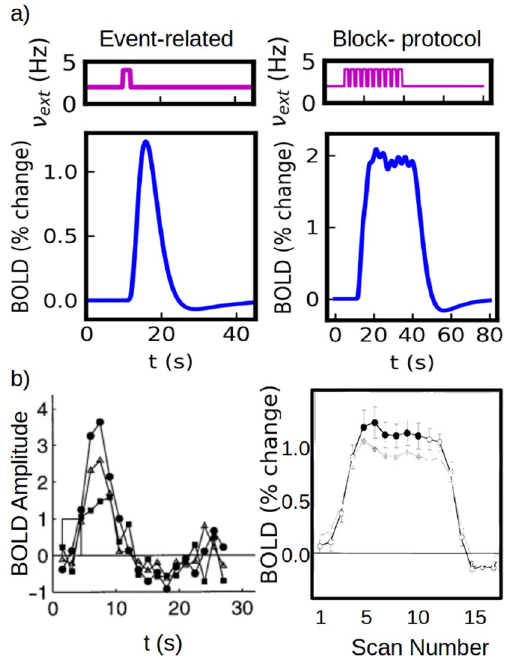
Figure 2. Standard experimental protocols for fMRI measurements. ( a ) Simulations of the event-related and block protocols. The event-related case consists in the application of a single stimulus of 2s. The block-protocol consists in the application of 10 stimuli of 2 seconds each, separated by an inter-stimulus interval of 1 second. ( b ) Experimental results for the two standard protocols. Left: results from an event-related protocol for three different stimulus strength (stimulus duration of 3 seconds), adapted from Ref. 49 . Right: results from a block protocol with 2.5 seconds stimulus and an inter-stimulus interval of 0.5 seconds, adapted from Ref. 48